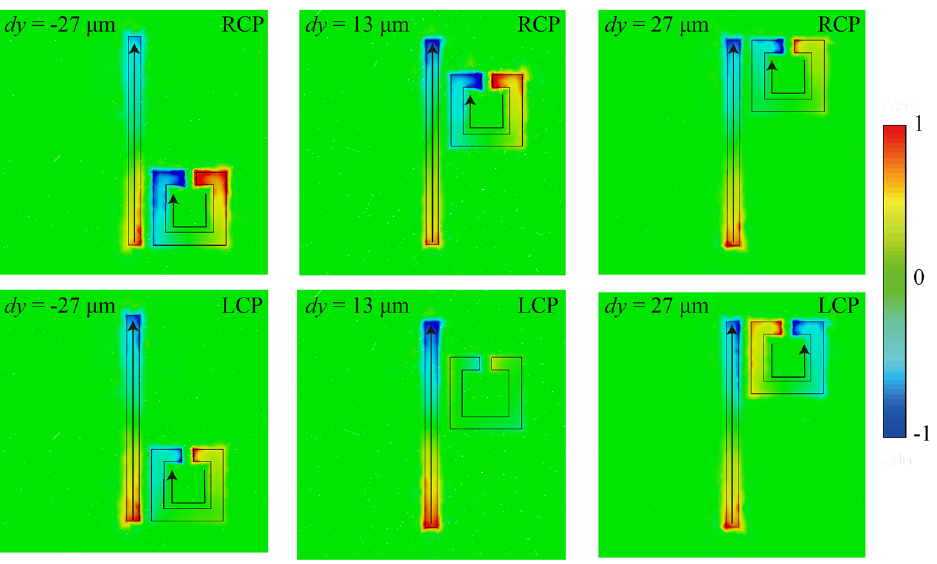
Figure 6: Normalized electric field distributions at different dy under RCP (upper panel) and LCP (lower panel) incident